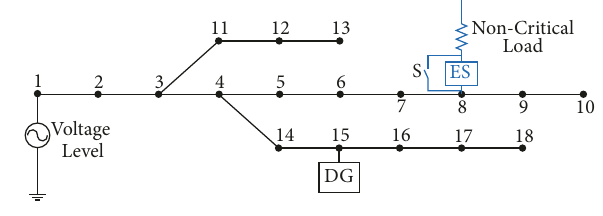
Figure 9: The simulation model of ADN.